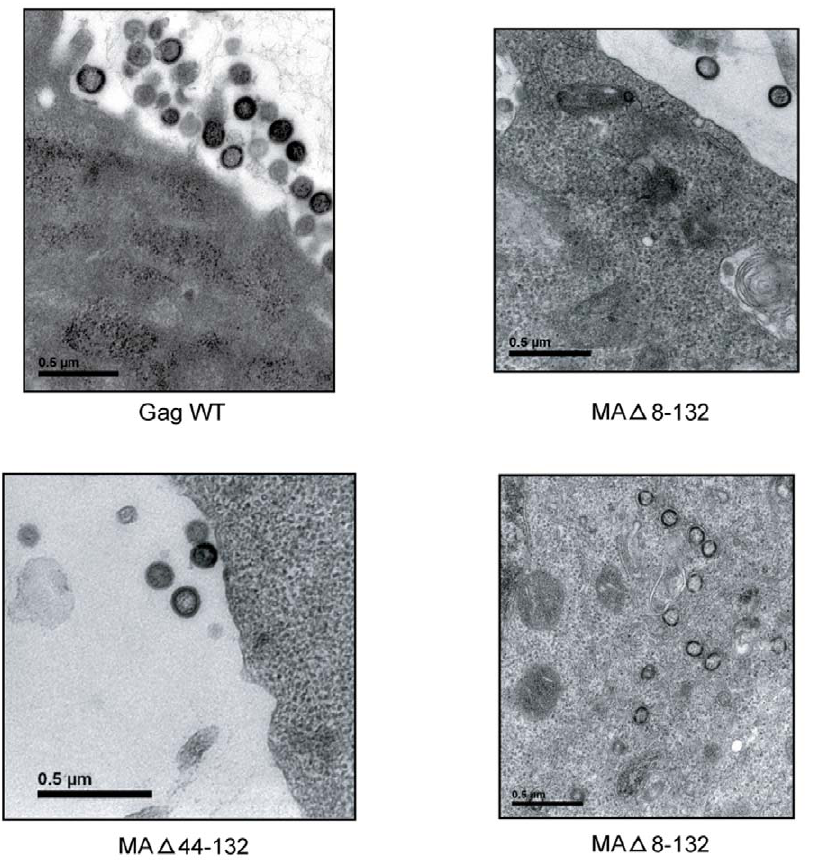
Figure 6. The Basic Region of MA allows a more efficient particle release. 293T cells expressing either Gag WT or MA mutants (i.e. MA D 8– 132 and MA D 44–132) were examined by TEM (magnification: 6 50,000). The microphotographs shown are representative of 2 independent experiments.